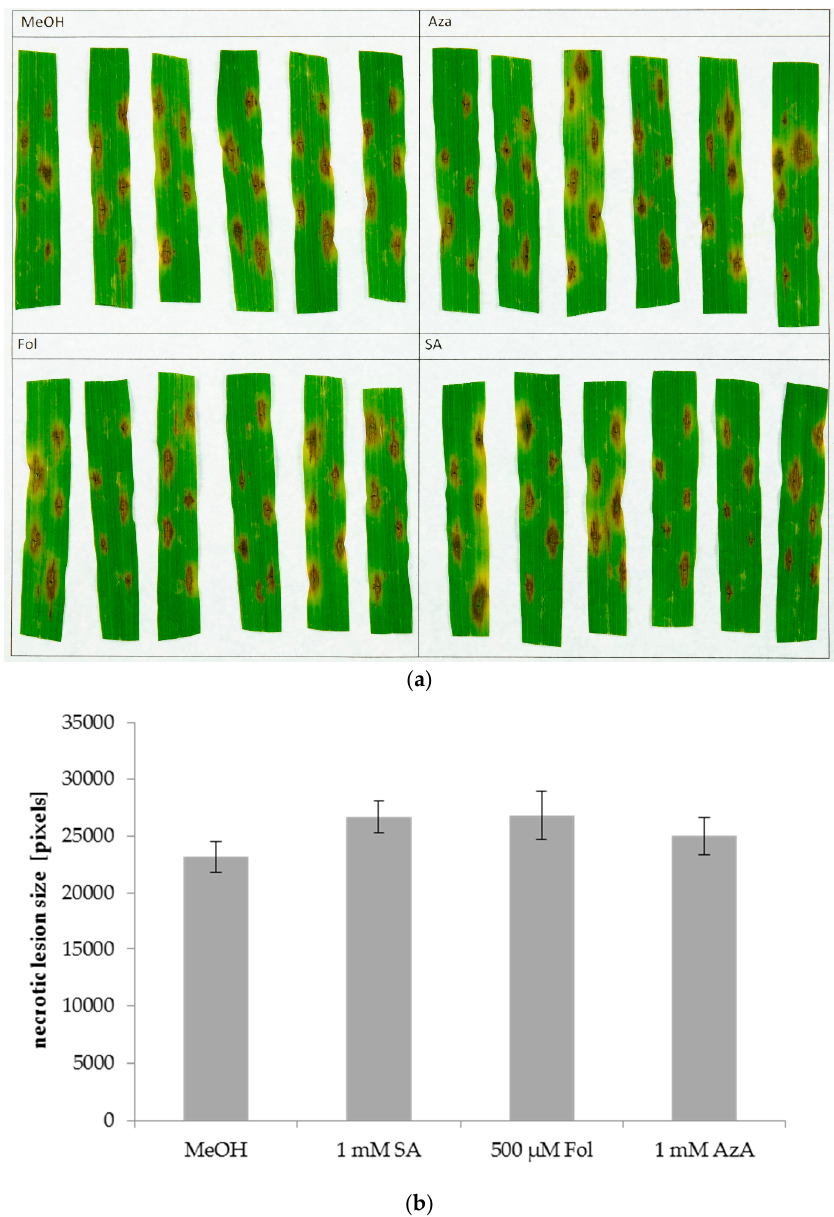
Figure 5. Lesions caused by Pyrenophora teres on the second leaves of barley after application of SA, Fol, or AzA on leaf 2. Barley cultivar GP plants were infiltrated in the second true leaf with 0.025% MeOH as control, 1 mM SA, 500 µM Fol, or 1 mM AzA in 10 mM MgCl 2 as indicated. One day later, the same leaves were inoculated with P. teres by pipetting droplets of a solution containing P. teres spores onto the leaf surface. The resulting necrotic lesions were photographed at 4 dpi ( a ) and measured using ImageJ ( b ). Bars in ( b ) represent the average of 35 replicates from 6 (Fol) or 42 replicates from 7 (all other treatments) independent experiments (each experiment with 6 replicates per treatment, except one experiment with Fol comprising 5 replicates) ± standard error.